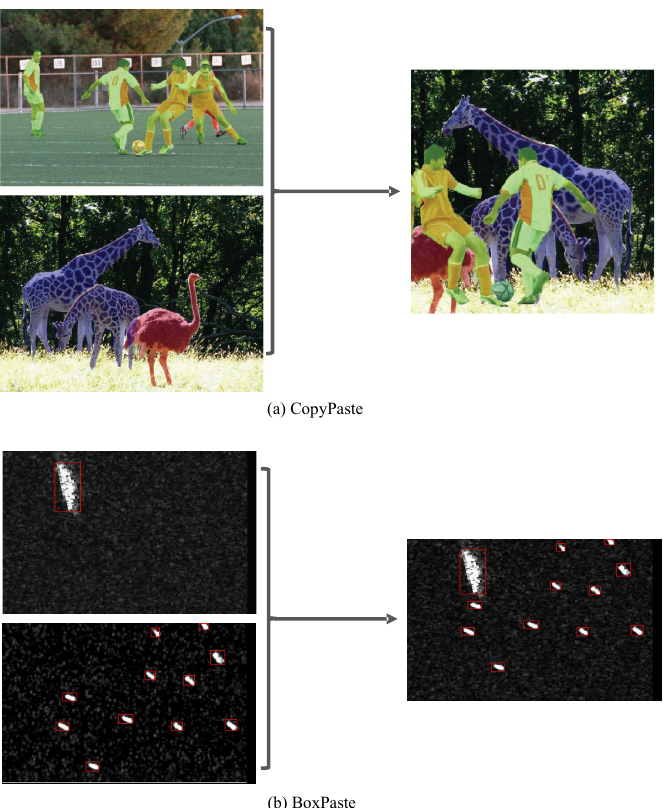
Figure 4. An illustration of CopyPaste [38] and our proposed BoxPaste. ( a ) is borrowed from the original paper. ( b ) shows a combination of two training images in the SSDD dataset. Note that for CopyPaste, ground-truth instance masks are required. However, applying BoxPaste in the SAR ship detection task only requires the bounding box annotations.